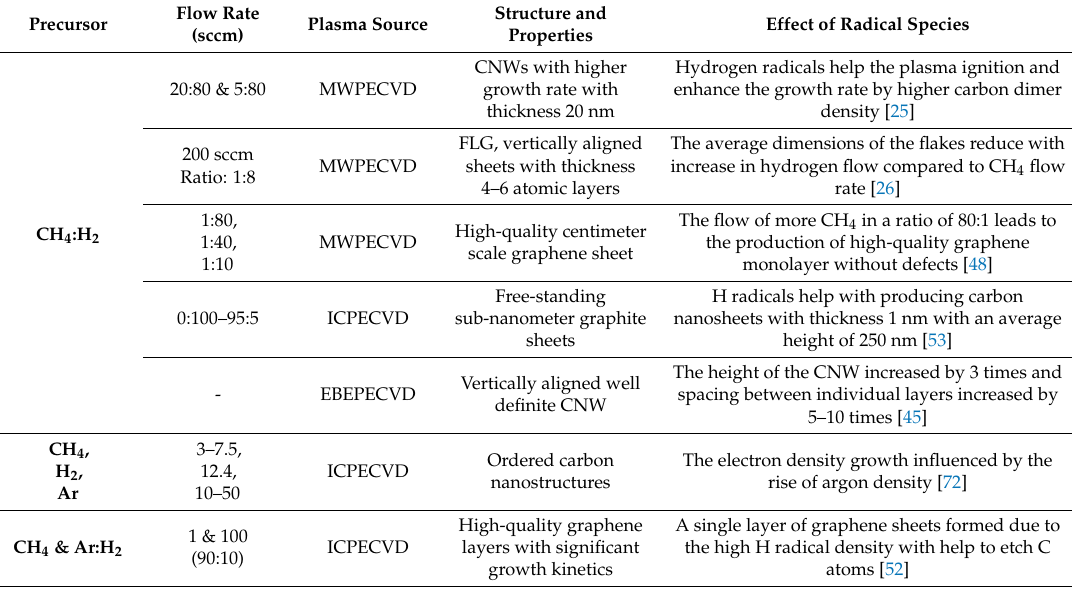
Table 2. Overview of different gases and plasma sources used for the synthesis of 2D carbon nanostructures and main influence of radical species